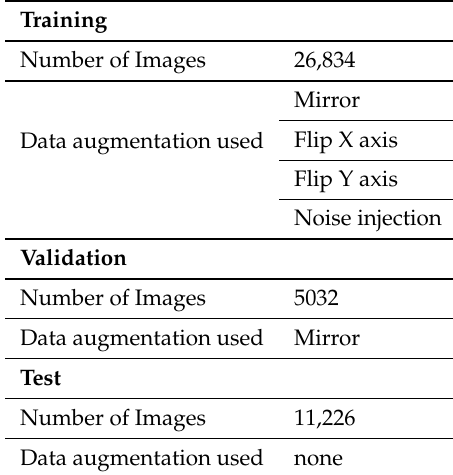
Table 2. TH70 dataset